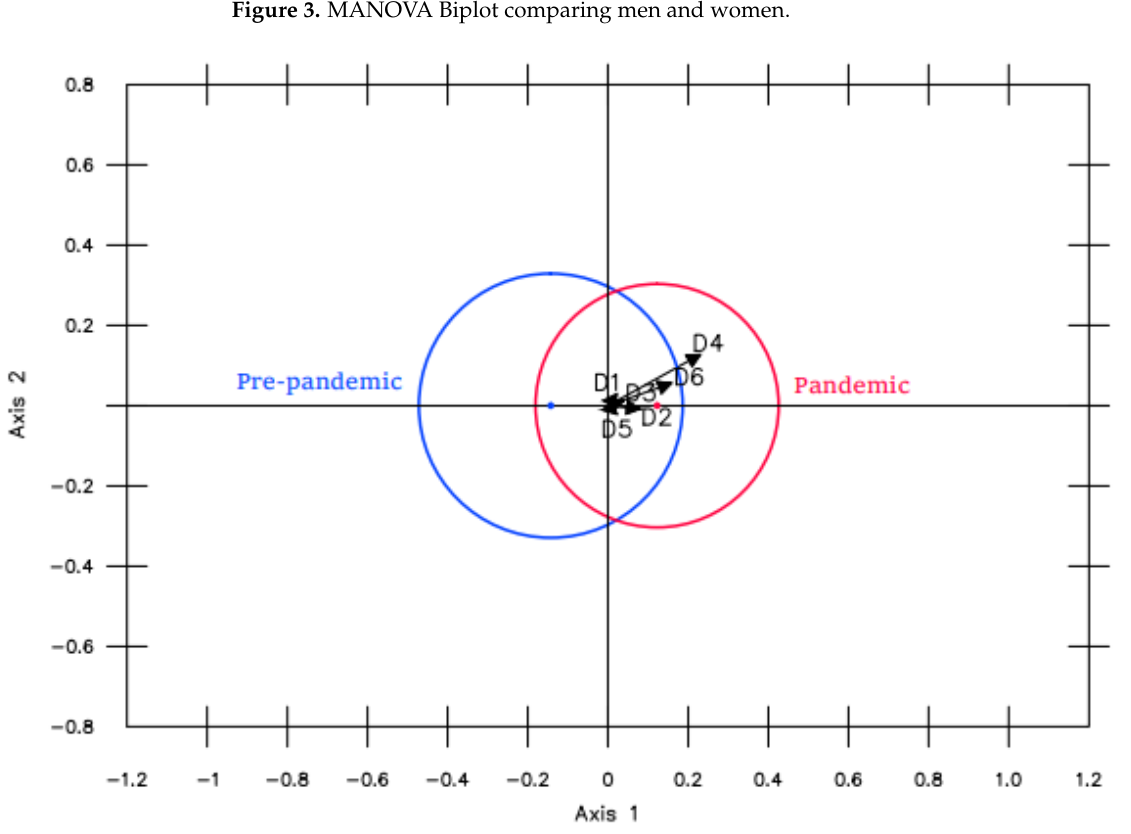
Figure 3. MANOVA Biplot comparing men and women.